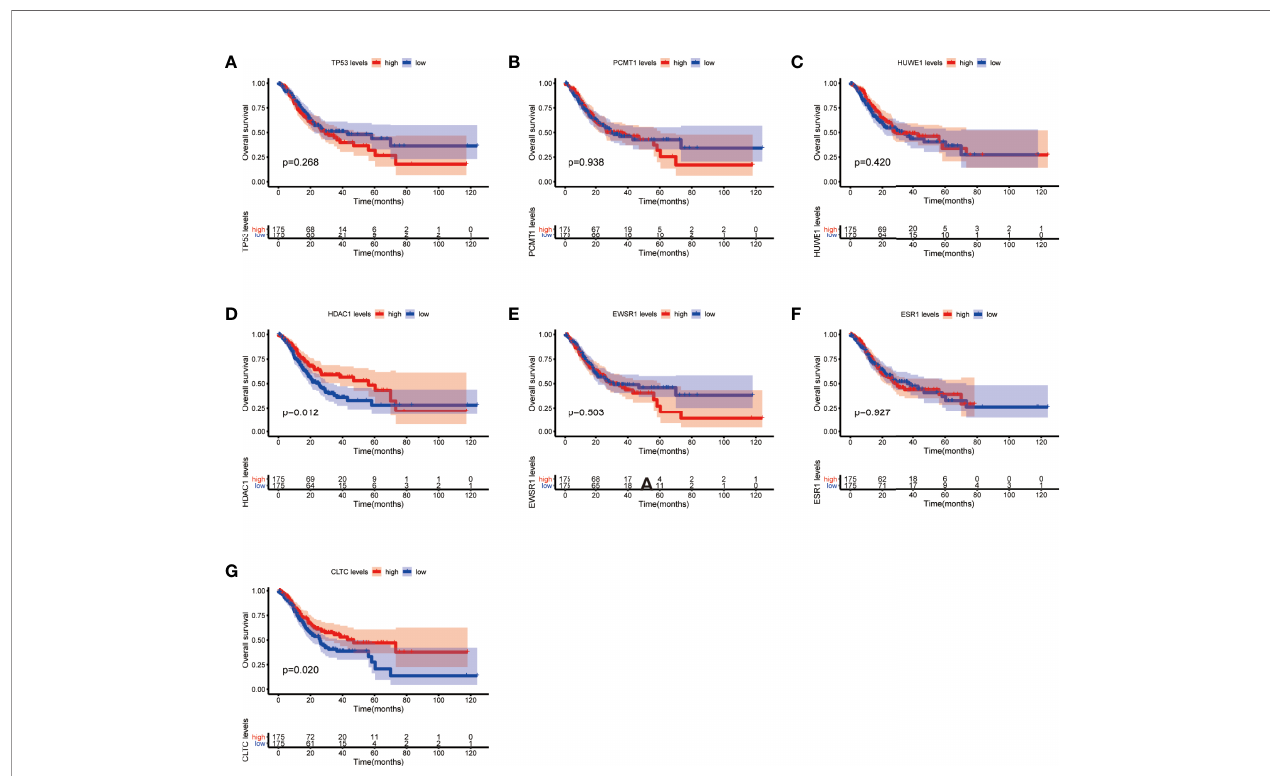
FIGURE 9 | Overall survival (OS) analysis of the seven hub genes in STAD patients from the TCGA database. (A) Survival analysis for TP53 in STAD. (B) Survival analysis for PCMT1 in STAD. (C) Survival analysis for HUWE1 in STAD. (D) Survival analysis for HDAC1 in STAD. (E) Survival analysis for EWSR1 in STAD. (F) Survival analysis for ESR1 in STAD. (G) Survival analysis for CLTC in STAD. The patients were strati fi ed into a high-level group (red) and a low-level group (blue) according to the median expression of the gene. Log-rank P < 0.05 was considered to be a statistically signi fi cant